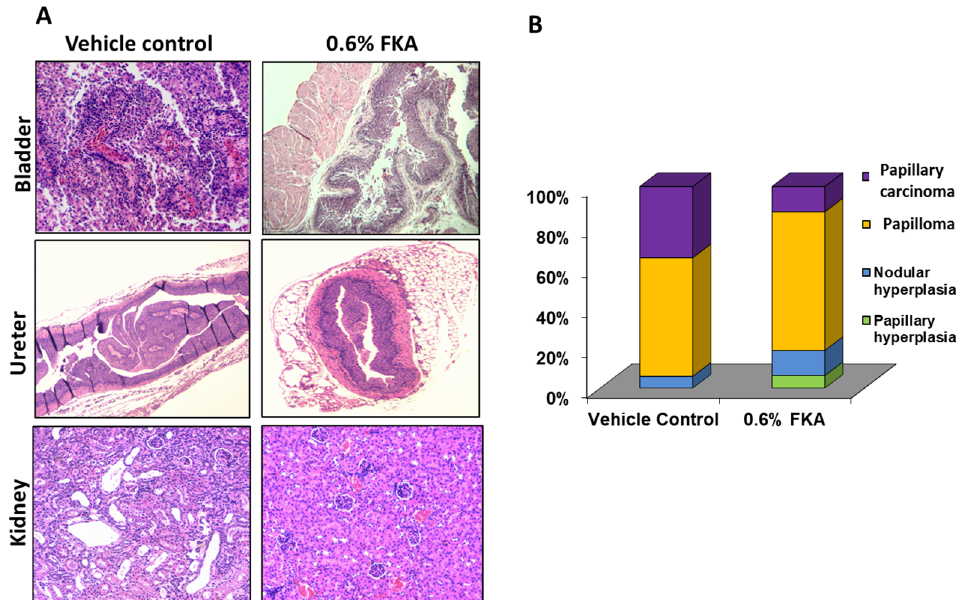
Figure 3. The chemopreventive efficacy of dietary FKA on pathological progression of urothelial carcinogenesis in male UPII-mutant Ha-ras transgenic mice. ( A ) Macroscopic examination of bladders, ureters, and kidneys after male UPII-mutant Ha-ras transgenic mice were fed with control diet or diet containing 0.6% FKA for 6 months. Magnification: 200×. ( B ) Percentages of papillary hyperplasia, nodular hyperplasia, papilloma, and papillary carcinoma after male UPII-mutant Ha-ras transgenic mice were fed with control diet or diet containing 0.6% FKA for 6 months.